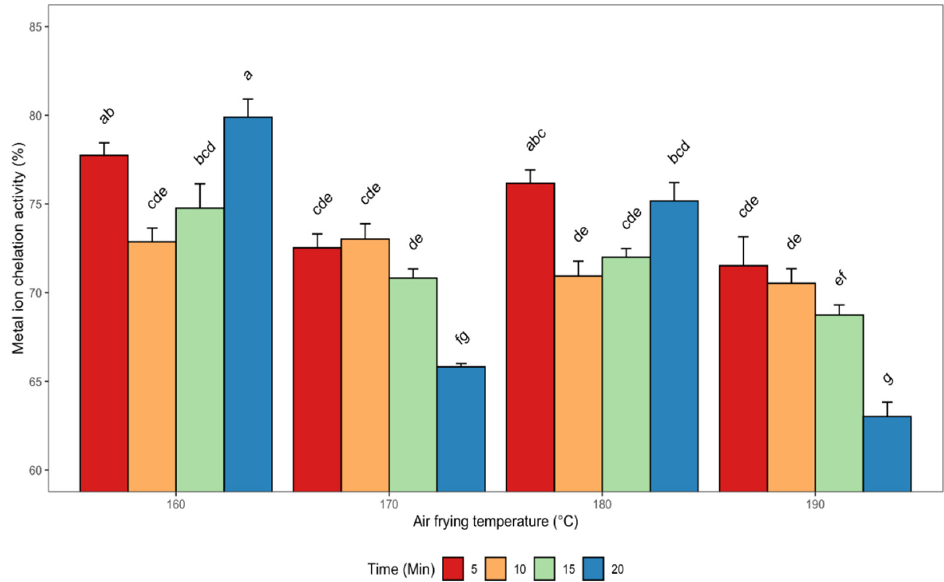
Figure 5. Changes in metal ion chelation activity (MIC) of de-oiled canola meal extracts as affected by different air frying conditions. Error bars indicate the SD of the measurements for each sample ( n = 3). Bars with different letters (a–g) have significantly ( p < 0.05) different mean values.